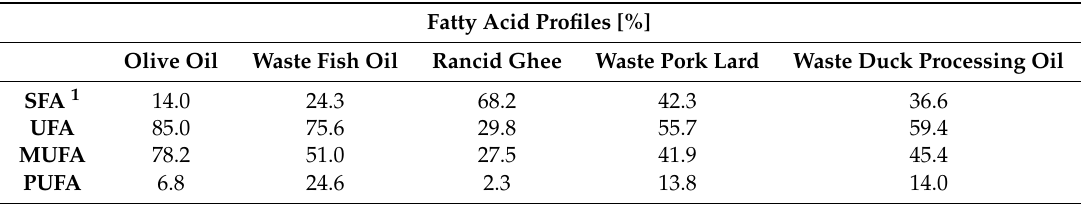
Table 1. Profiles of fatty acids in olive oil and lipid-rich food industry wastes [%]. Fatty Acid Profiles [%] Olive Oil Waste Fish Oil Rancid Ghee Waste Pork Lard Waste Duck Processing Oil SFA 1 14.0 24.3 68.2 42.3 36.6 UFA 85.0 75.6 29.8 55.7 59.4 MUFA 78.2 51.0 27.5 41.9 45.4 PUFA 6.8 24.6 2.3 13.8